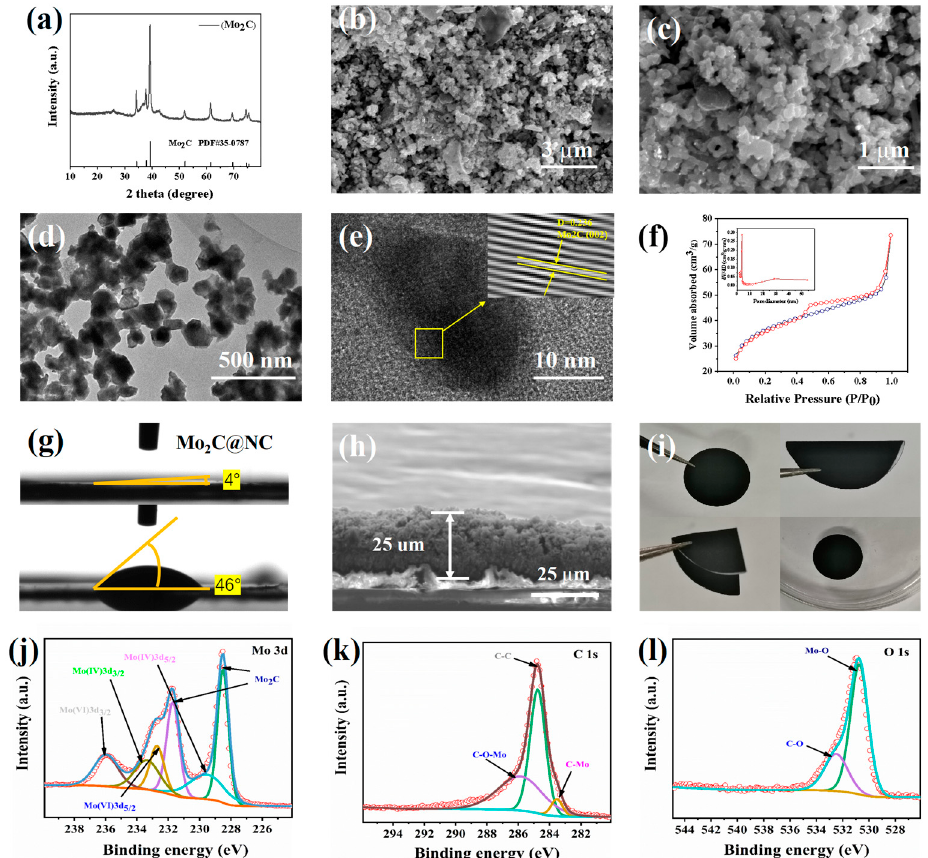
Figure 2. ( a ) XRD pattern of Mo 2 C/C. ( b , c ) SEM images of the agarose gel precursor and the corresponding Mo 2 C/C. ( d , e ) HRTEM images Mo 2 C/C. ( f ) BET and pore size distribution of Mo 2 C/C. ( g ) Electrolyte contact angle on the original PP and Mo 2 C/C@PP separators. ( h ) Cross-sectional view of the Mo 2 C/C@PP separator. ( i ) Digital photos of Mo 2 C/C separators under different test conditions. ( j ) Full spectrum, ( k ) Mo 3d, ( l ) C 1s, and ( d ) O